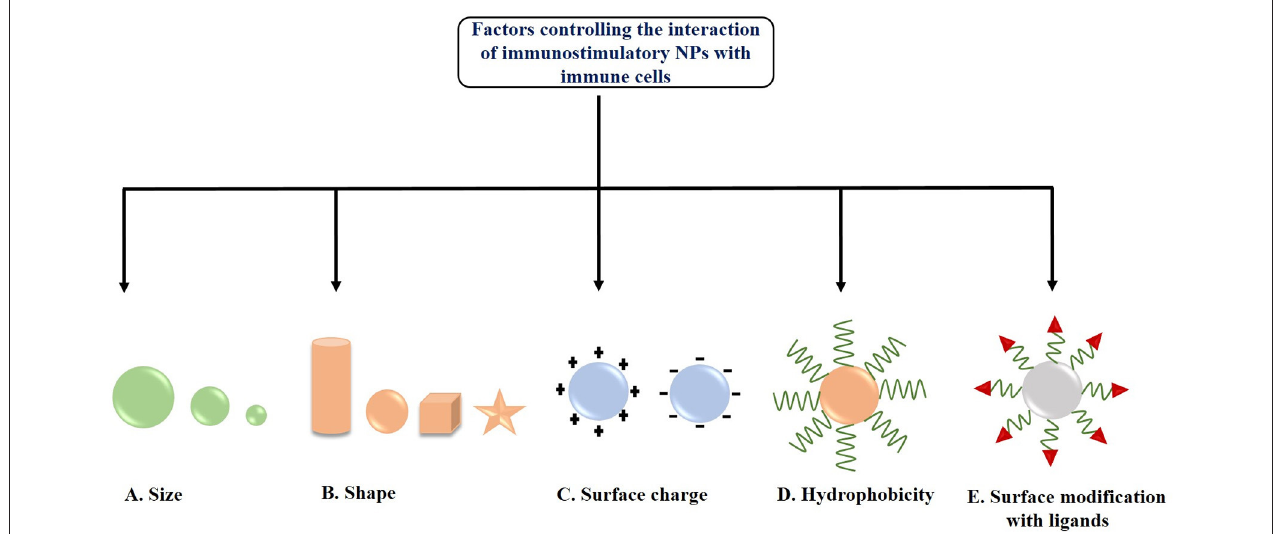
FIGURE 3 | Factors controlling the interaction of immunostimulatory nanoparticles (NPs) with immune cells (A) Size, (B) Shape, (C) Surface charge, (D) Hydrophobicity, and (E) Surface modification with